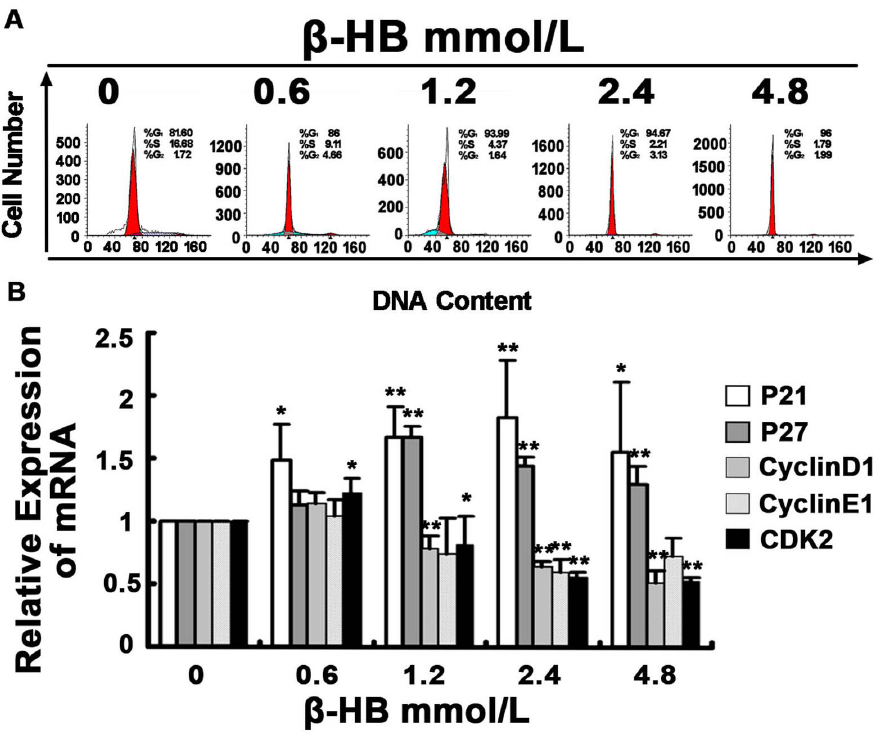
Figure 8. Effect of b -HB on cell cycle. Cells were incubated 48 h with b -HB (0, 0.6, 1.2, 2.4 or 4.8 mM) in serum-free medium. A) Cell cycle analysis was performed by flow cytometry to determine the percentage of cells in the G1, S, and G2 phases. B) The mRNAs of P21, P27, cyclin D1, CDK2 and cyclin E1 were detected by Q-PCR, and the ratios of these mRNA levels to b -actin were calculated. The mean of three independent experiments is shown. *p , 0.05, **p , 0.01 versus control group.